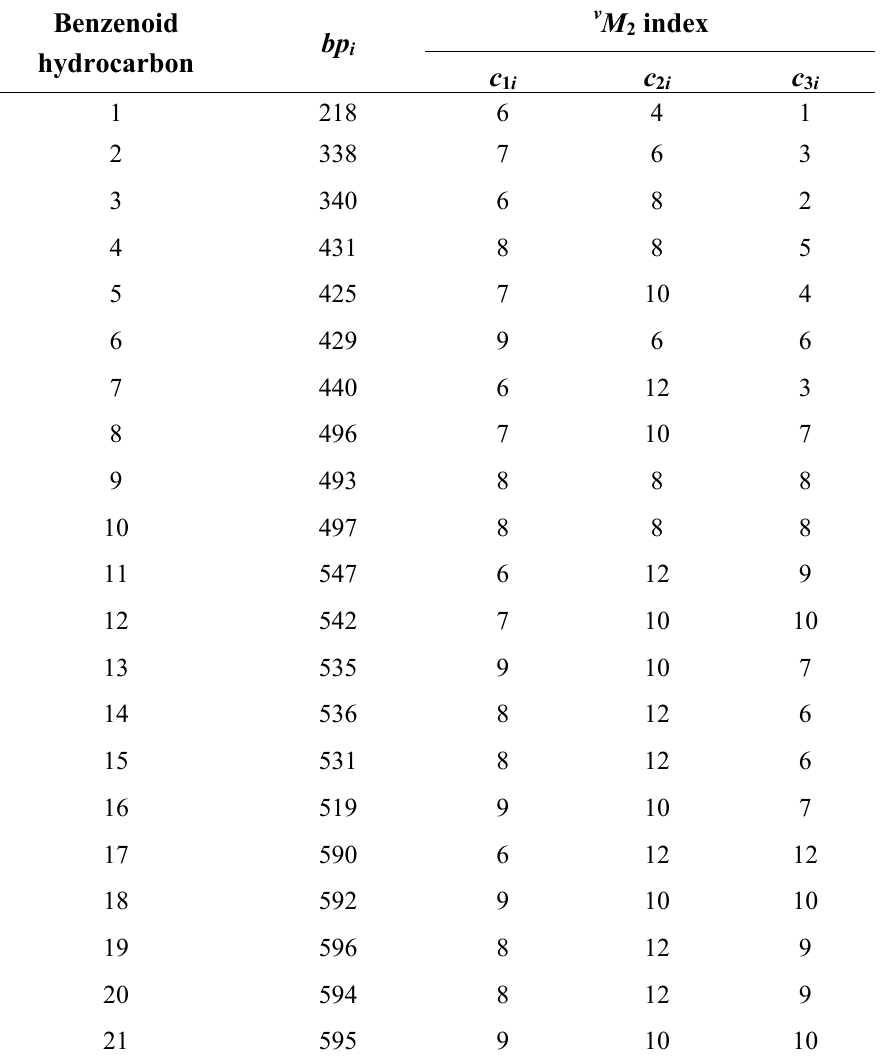
Table 1. The values of experimental boiling points ( bp coefficients ( c benzenoid